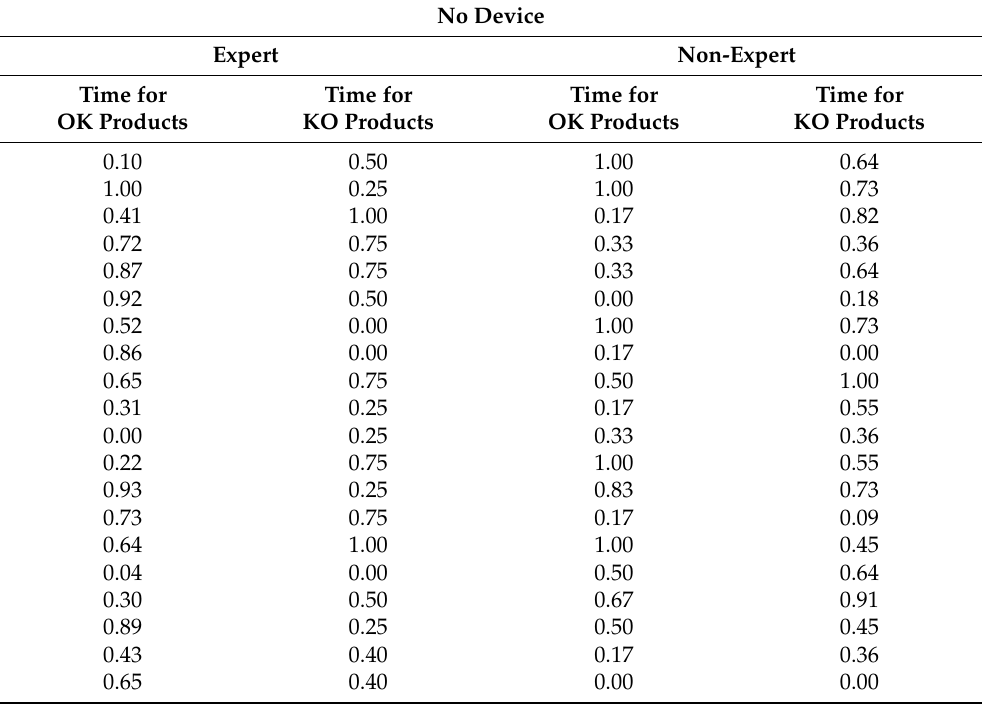
Table 7. Normalized duration of the quality control procedure made by expert and non-expert operators without AR devices, differentiating by compliant (OK) and non-compliant (KO)